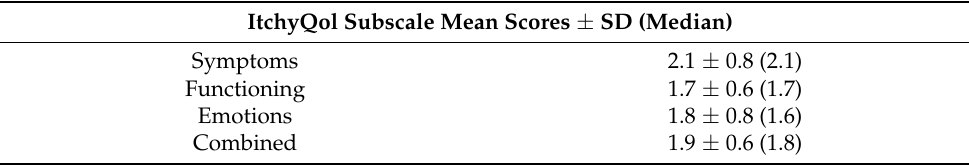
Figure 4. Spearman’s correlation analysis revealed a significant positive link between itch intensity measured with Four-Item Itch Questionnaire (4IIQ) and life impairment due to itch measured with ItchyQoL (itch-specific quality of life questionnaire) (R = 0.5, p < 0.01). Table 5. ItchyQoL subscale results among patients with itch in type 2 diabetes